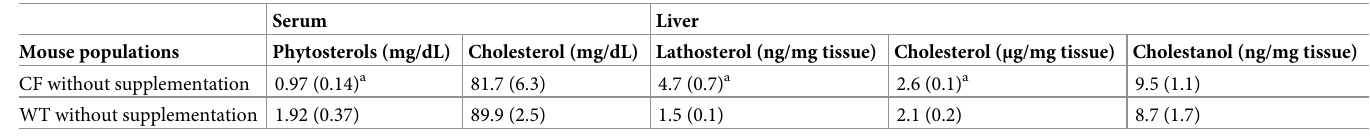
Table 3. Comparison of sterol levels in CF and WT mice without cholesterol-supplementation. Serum Liver Mouse populations CF without supplementation 0.97 (0.14)